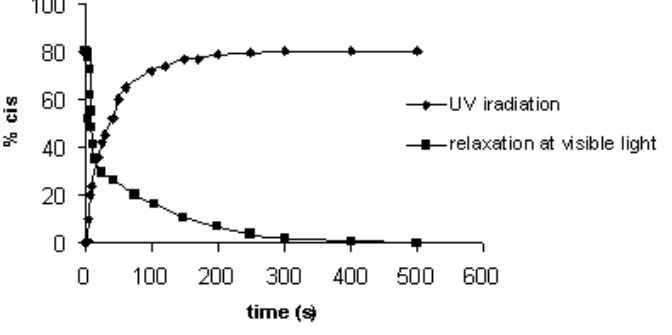
Fig. 10 The kinetic curves corresponding to the trans-cis isomerization and cis-trans relaxation processes of Sample 2 (in solid state).